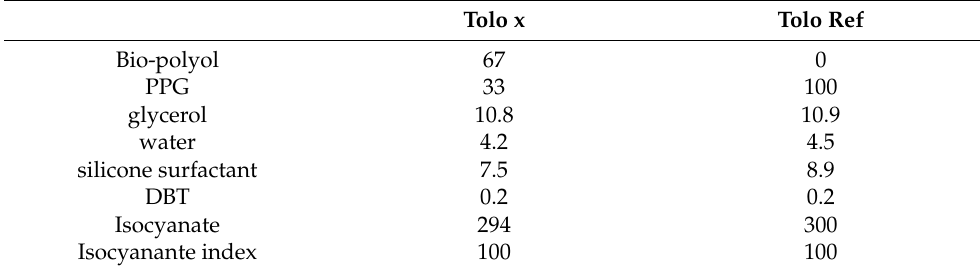
Table 3. Formulation of the foams used in this study.